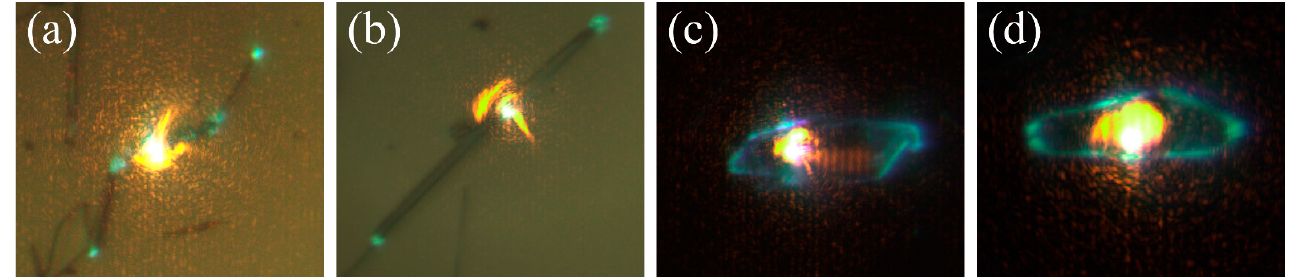
Figure 10. Optical microscopy images show the guidance of light that occurs within the structures, either in elongated structures ( a , b ) or in plates ( c , d ). The orange dot is the excitation laser (325 nm), while the blue-green light points correspond to the emission generated by photoluminescence that has been guided to the